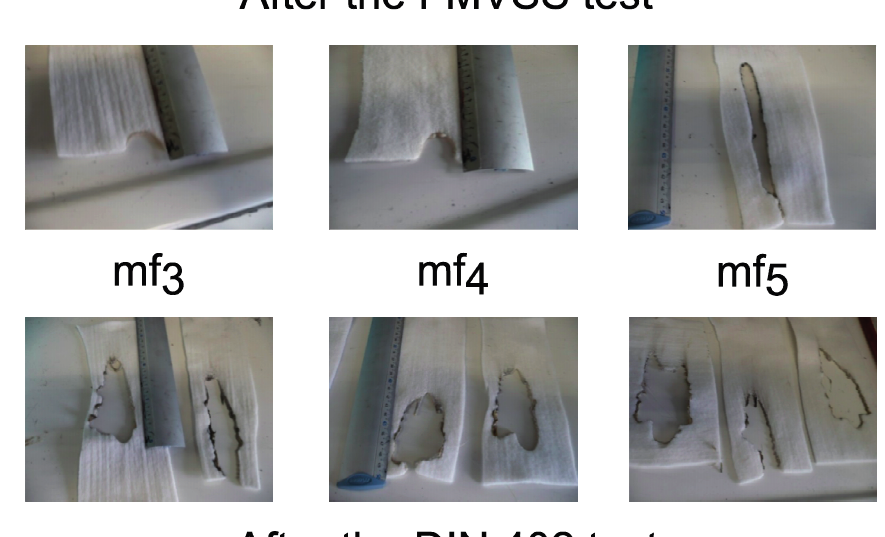
Figure 2. Images of the FMVSS and DIN 402 exposed samples.